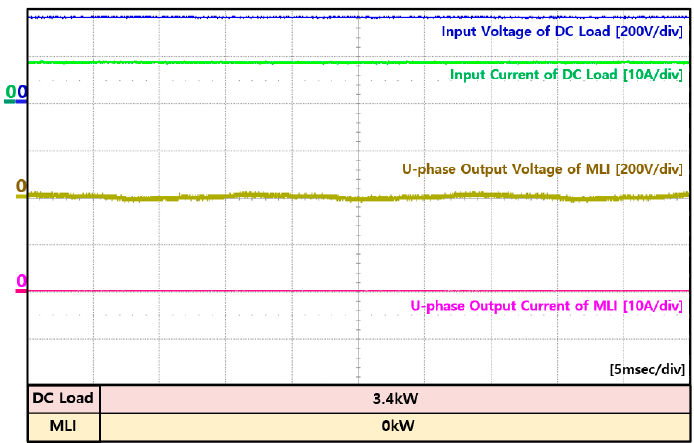
Figure 16. Experiment waveforms of DC load and multi-level inverter in mode 2.